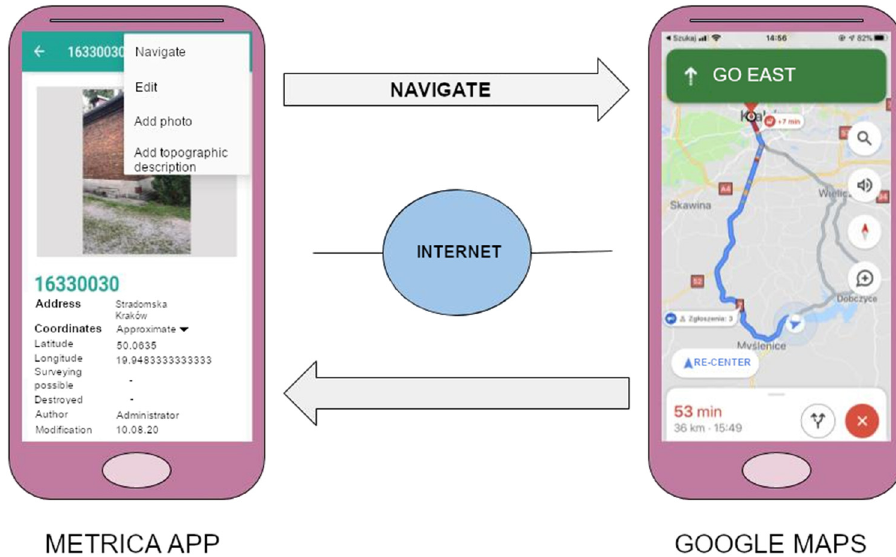
Figure 2: Data presentation in the proprietary METRICA application. Source: Authors ’ original